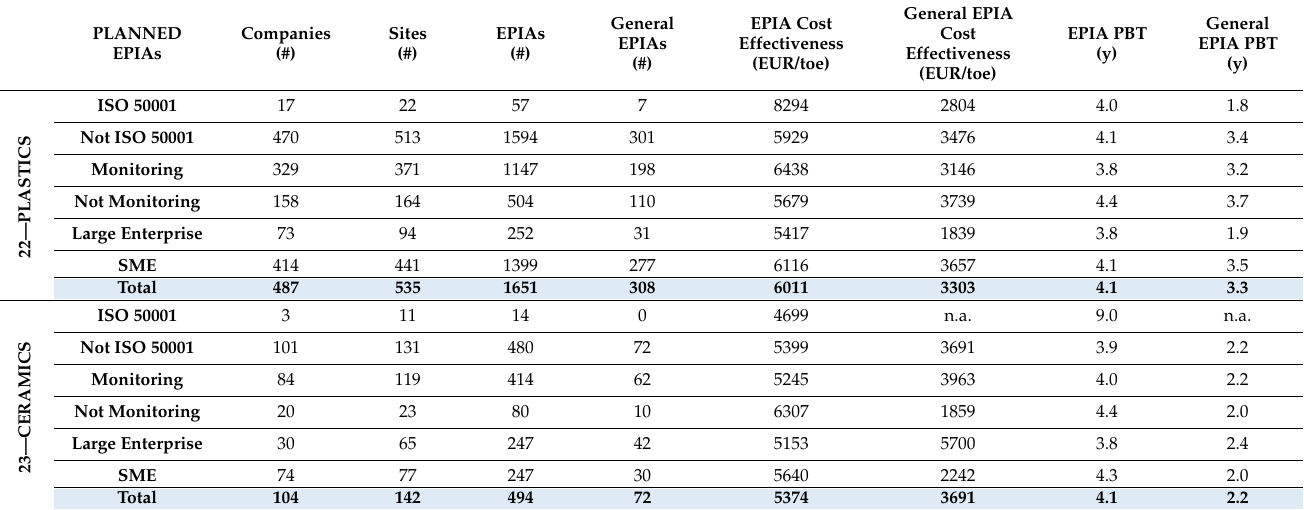
Table 2. Plastic and ceramic sector planned